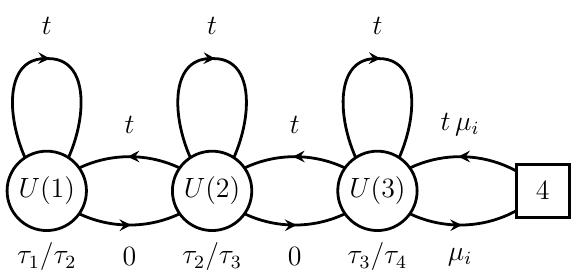
Figure 4 . 3 d T [SU(4)] gauge theory. (cid:28) a are the FI parameters. The masses of the chirals are indicated over or under the corresponding